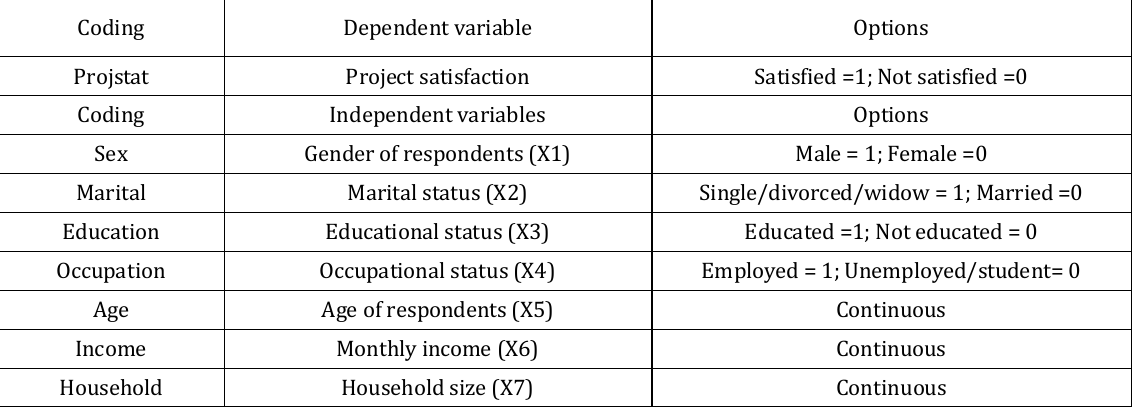
Table 7. Operationalization of variables